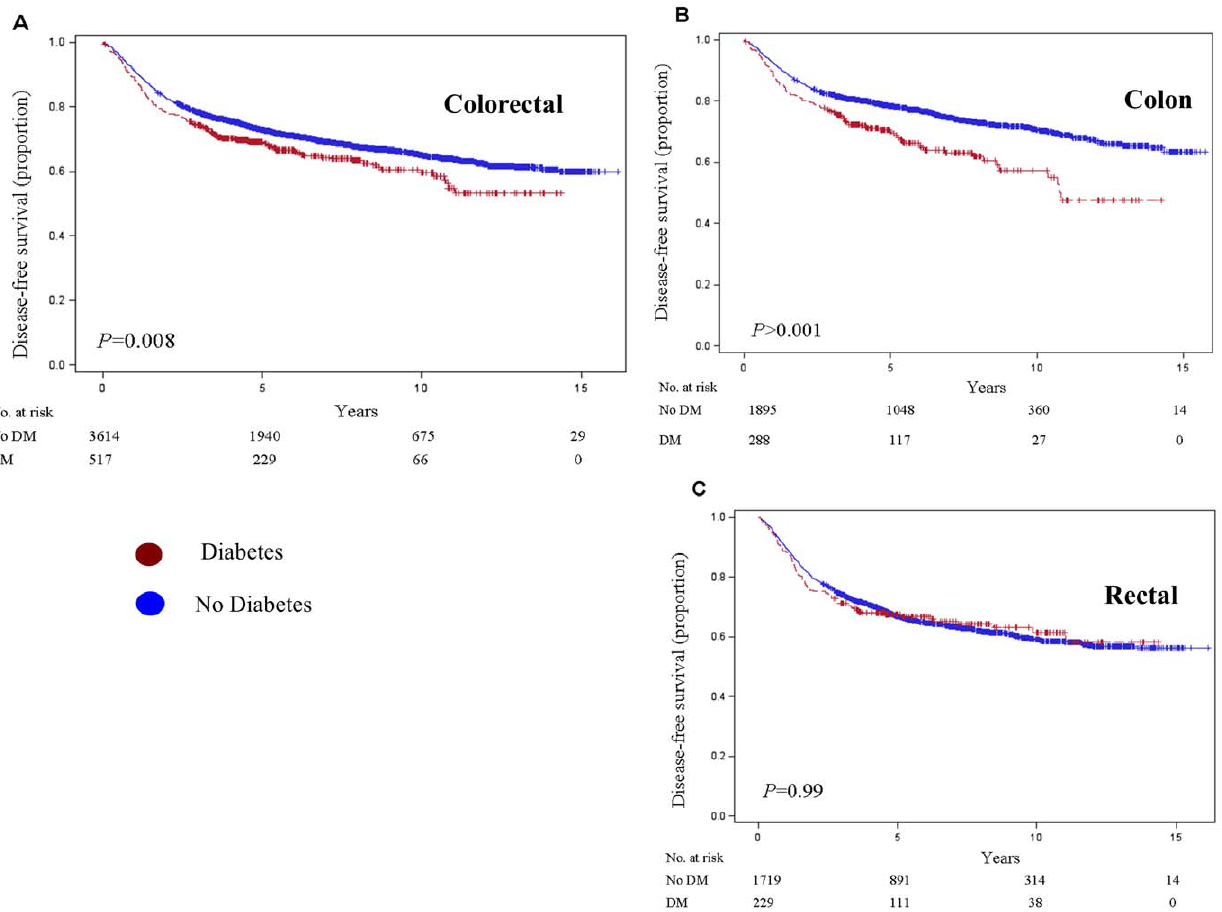
Figure 1. Kaplan-Meier survival curve for disease-free survival in colorectal (A), colon (B) and rectal (C) cancer patients staged I to III by diabetes mellitus status.